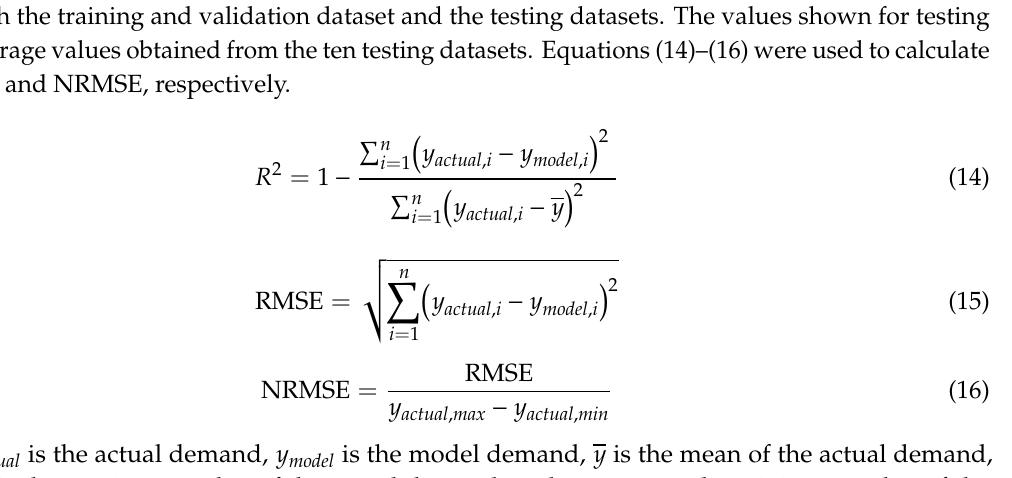
Figure 16. Frequency profile that corresponds to the energy demand profile presented in Figure 15.